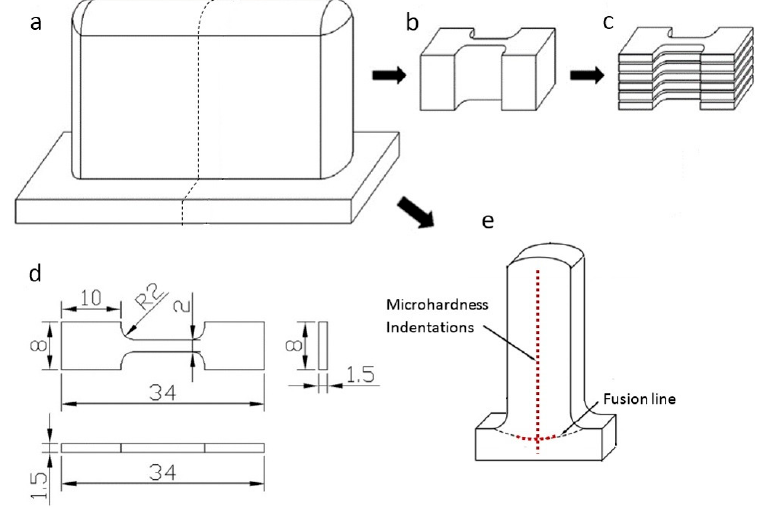
Figure 4. Sample preparation: ( a ) wall structure and the middle cutting trajectory; ( b ) bulk tensile sample cut from the sub-wall; ( c ) tensile specimens after slicing bulk sample; ( d ) dimensions of miniature tensile specimens in mm; and ( e ) wire-cut cross-section for microstructure observations and hardness testing.